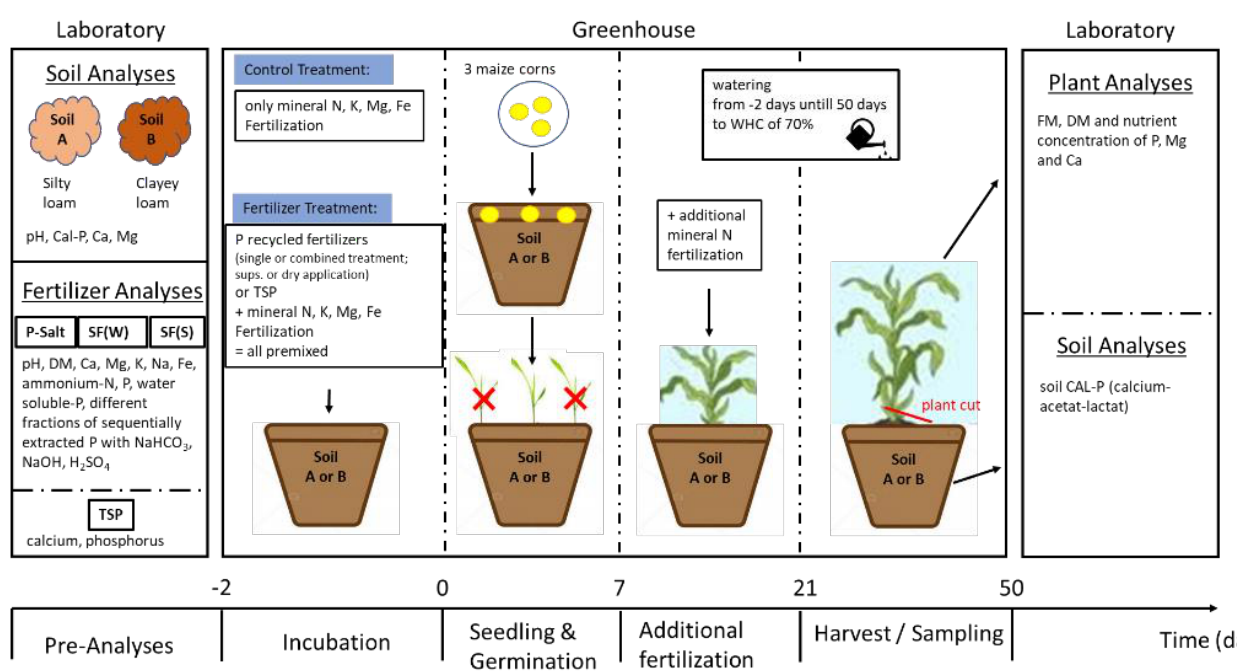
Figure 2. Overview of the experimental set-up of the greenhouse pot experiment with maize. Fertilizer fractions tested were P-Salt (P-enriched precipitate from the liquid fraction), SF (W) (air-dried solid fraction), SF(S) (steam-dried solid fraction), and different combinations of them, compared to unfertilized control and triple superphosphate (TSP). Maize plants were cultivated for 50 days in a silty loam and clay loam soil. DM—dry matter; FM—fresh matter; Ca—calcium;